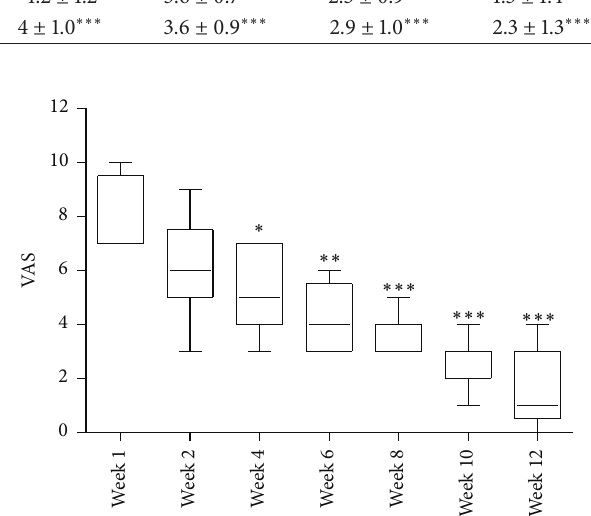
Figure 1: Time course self-reported postoperative visual analogue pain score (VAS) from patients with plantar fasciosis, showing median and minimum and maximum scores, where ∗∗∗ 𝑝 < 0.001 versus preop (week 1) VAS.